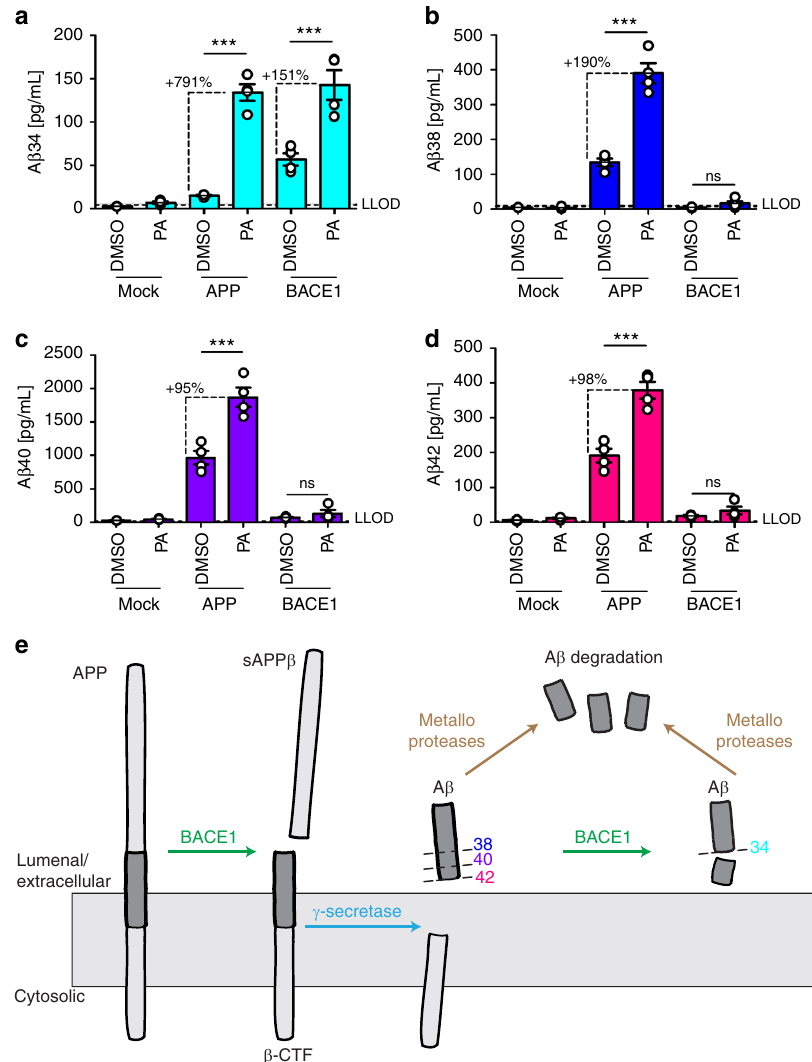
Fig. 5 A β 34 degradation by PA-sensitive metalloproteases. Using SH-SY5Y cells stably expressing APP695 or BACE1, MSD multiplexing to quantify the absolute amounts of A β 34 ( a ), A β 38 ( b ), A β 40 ( c ), and A β 42 ( d ) was performed. Data were collected from four independent experiments. Bars and error bars indicate mean ± s.e.m. Data were analyzed with two-way ANOVAs and signi fi cant interactions were followed up with simple main effects @treatment. *** p < 0.001, ns = nonsigni fi cant p > 0.05. a A β 34, interaction F (2, 18) = 23.93, p < 0.0001, simple main effects @Mock F (1, 18) = 0.12, p > 0.05, @APP F (1, 18) = 97.02, p < 0.0001, @BACE1 F (1, 18) = 50.41, p < 0.0001, b A β 38, interaction F (2, 18) = 63.26, p < 0.0001, simple main effects @Mock F (1, 18)